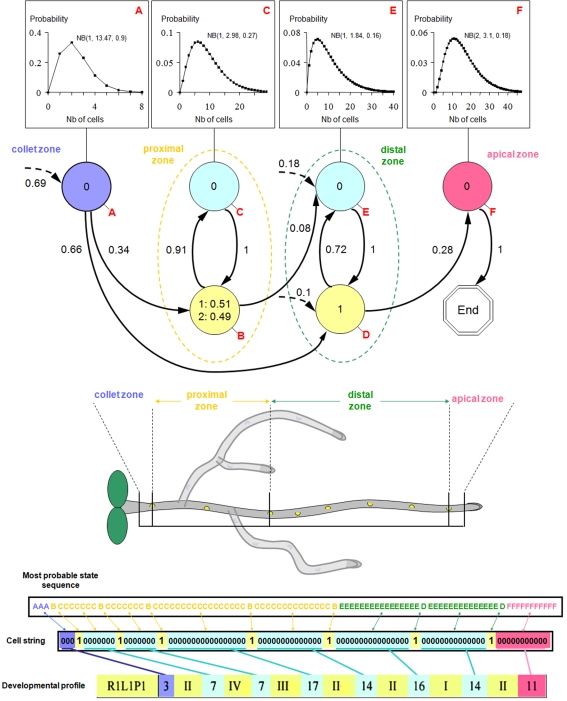
Stochastic model of root development.This model represents all observed developmental profiles (400 seedlings aged from 3 to 12 days). Each state is represented by a vertex which is labeled in red in its lower right corner (except the final end state). The possible transitions between states are represented by arcs with the attached probabilities noted nearby. Dotted arcs entering in states indicate initial states. The attached initial probabilities are noted nearby. Only arcs with attached initial or transition probabilities >0.03 are figured. The occupancy distributions of the semi-Markovian states A, C, E, and F are figured above the corresponding vertex. All these occupancy distributions are negative binomial distributions NB(d, r, p). The possible outputs in a state are noted in the corresponding vertex with the attached observation probabilities when <1. States B–C (respectively D–E) define the proximal (respectively distal) functional zones. The lower part of the panel present the most probable state sequence predicted for the given cell string.